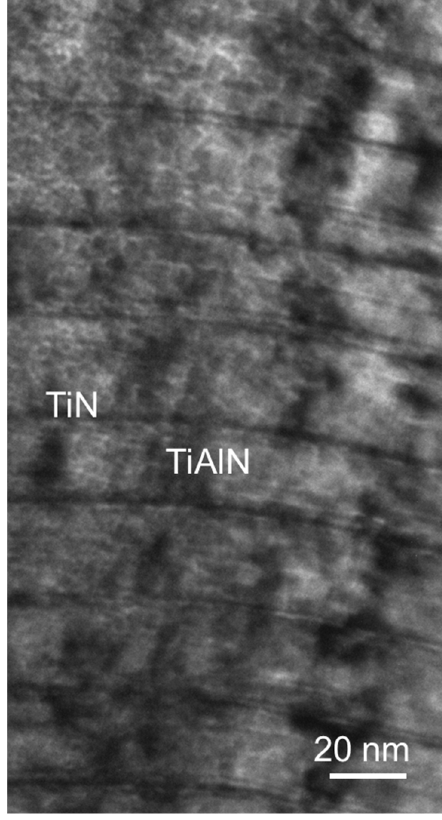
Figure 4. Cross-sectional TEM image of TiAlN/TiN